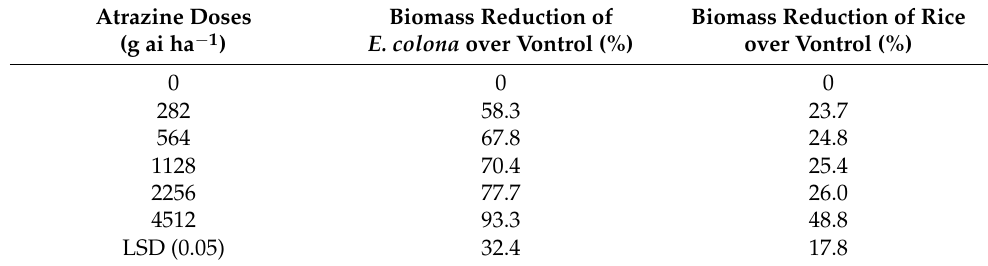
Table 2. Effect of atrazine on percent biomass reduction of Echinochloa colona control and rice. Atrazine Doses Biomass Reduction of E. colona over Vontrol (%) (g ai ha − 1 )